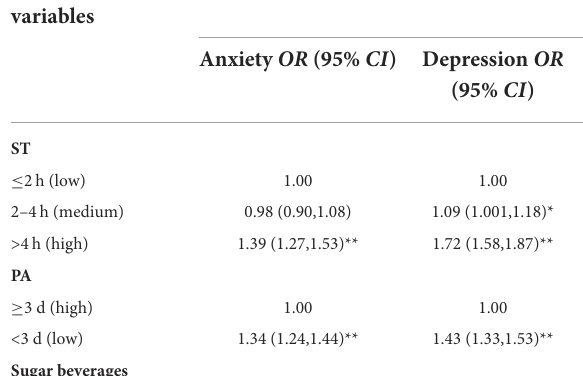
TABLE 5 The association between health behaviors and mental health among college students.